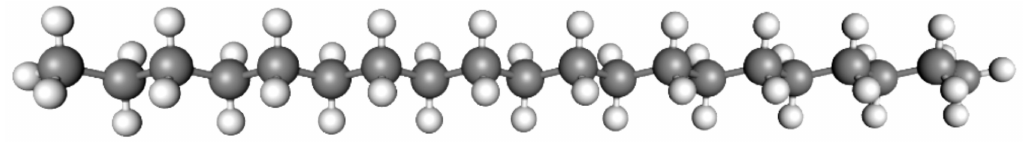
Figure 1. Structure of the lowest energy chain